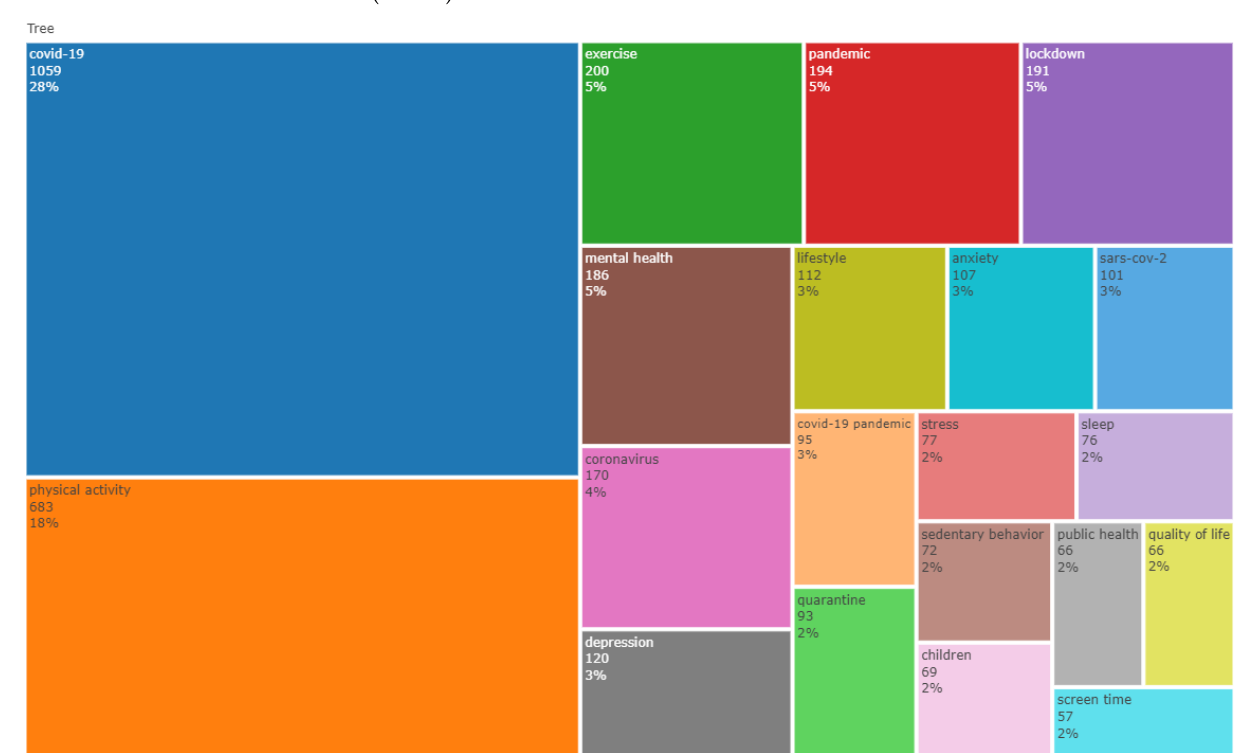
Figure 3. Treemap of the most prominent author’s keywords ( n = 20) .